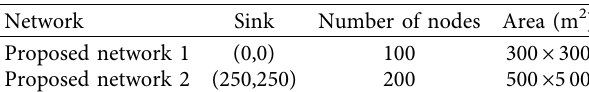
Table 3: Simulations